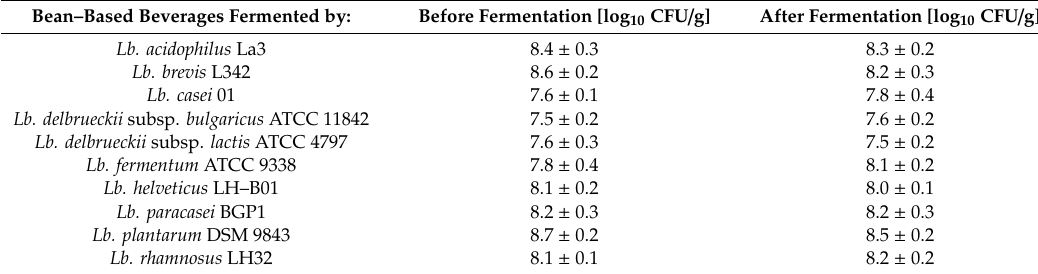
Table 1. Population of lactobacilli in bean–based beverages (means ± standard deviations, n =